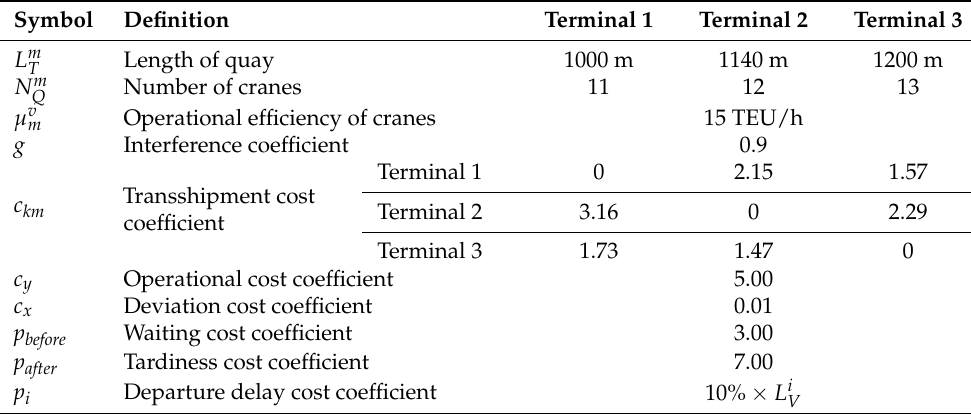
Table 2. Data of terminals in the container port.